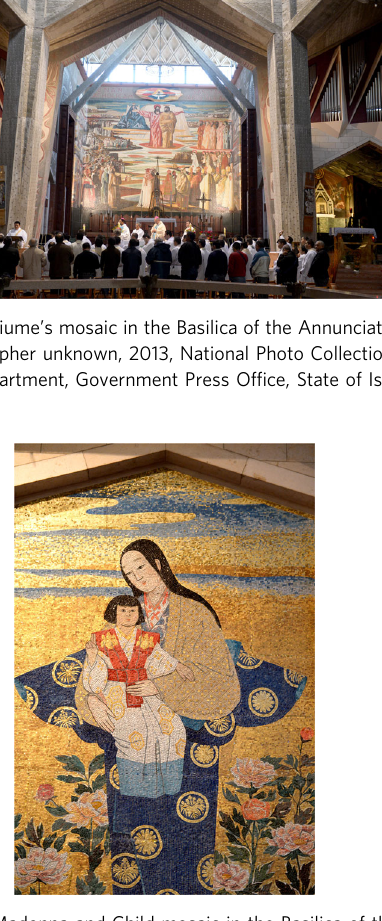
Fig. 7 Japanese Madonna and Child mosaic in the Basilica of the Annunciation ’ s upper church (Photographer unknown, 2013, National Photo Collection, Photography Department, Government Press Of fi ce, State of Israel).